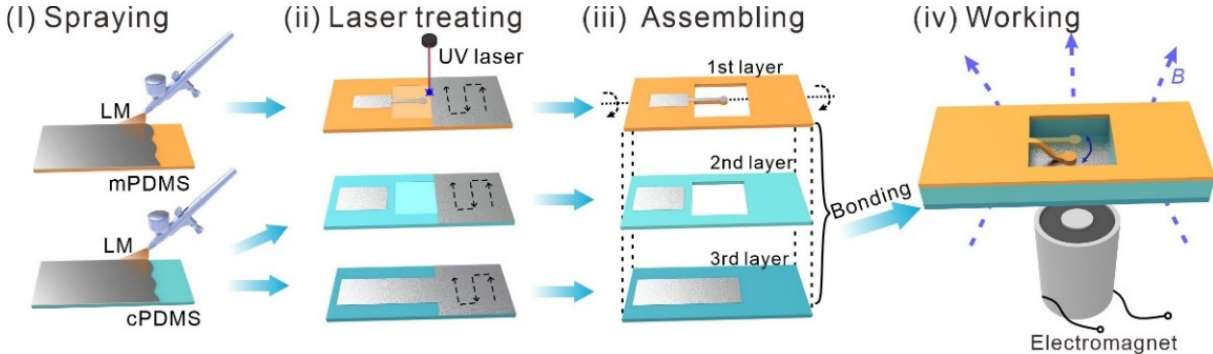
Figure 3. Fabrication process of the MCSM.